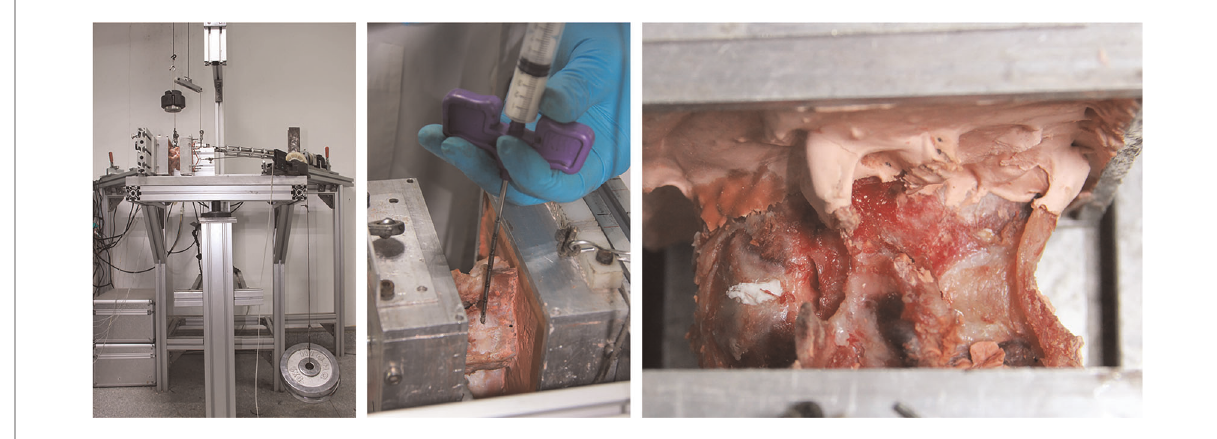
FIGURE 2 Construction of the nucleotomy condition.